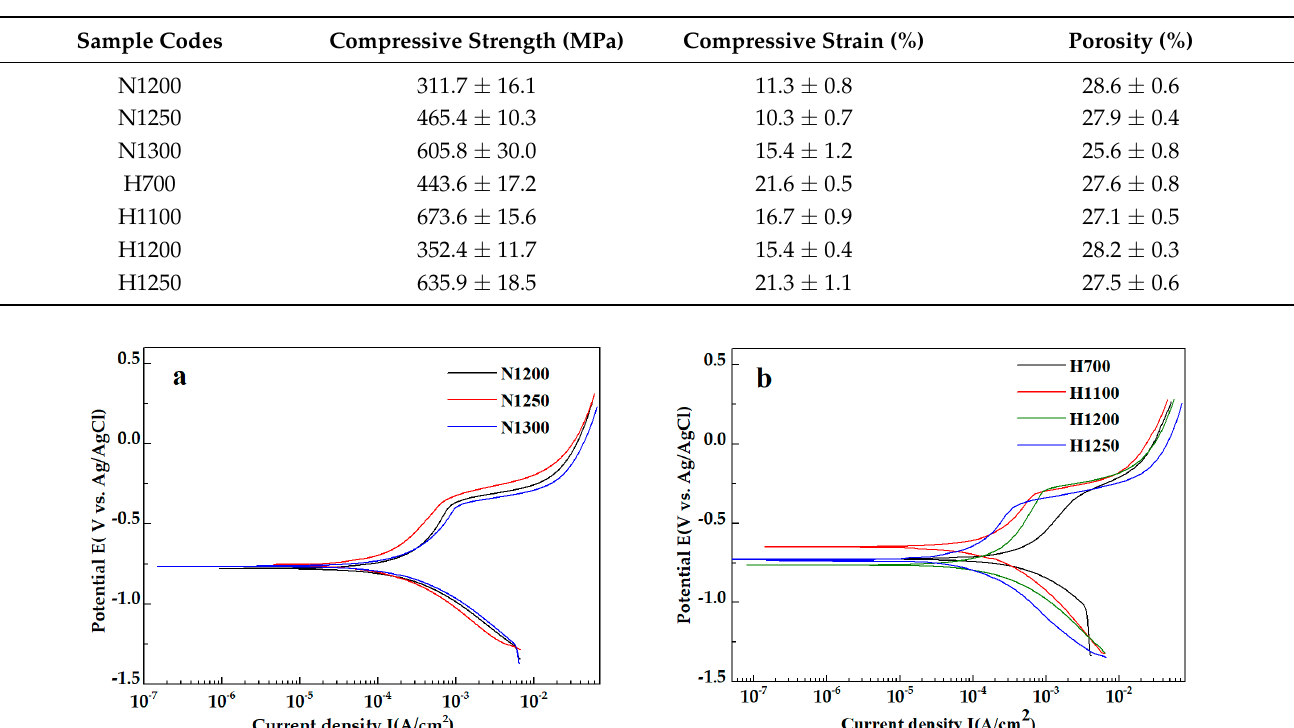
Figure 7. Engineering compressive stress–strain curve of the as-fabricated porous HNASS samples. ( a ) unreduced samples N1200, N1250 and N1300, ( b ) reduced samples H700, H1100, H1200 and H1250. Table 7. Compressive strength and elastic modulus of porous HNASS samples.